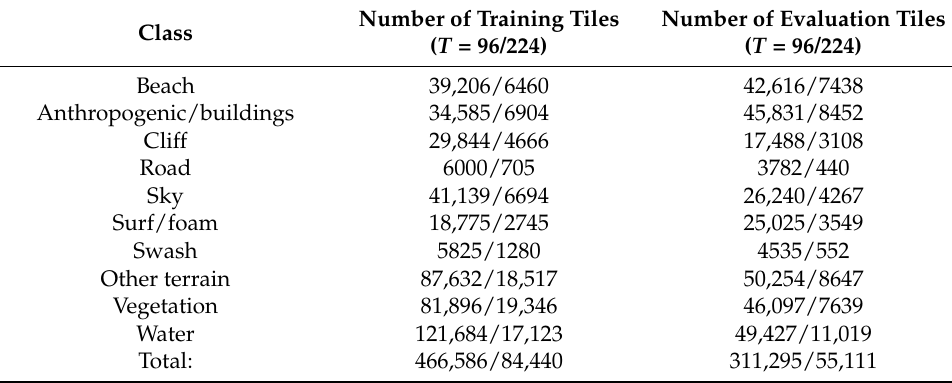
Table A4. Classes and number of tiles used for the California Coastal Records